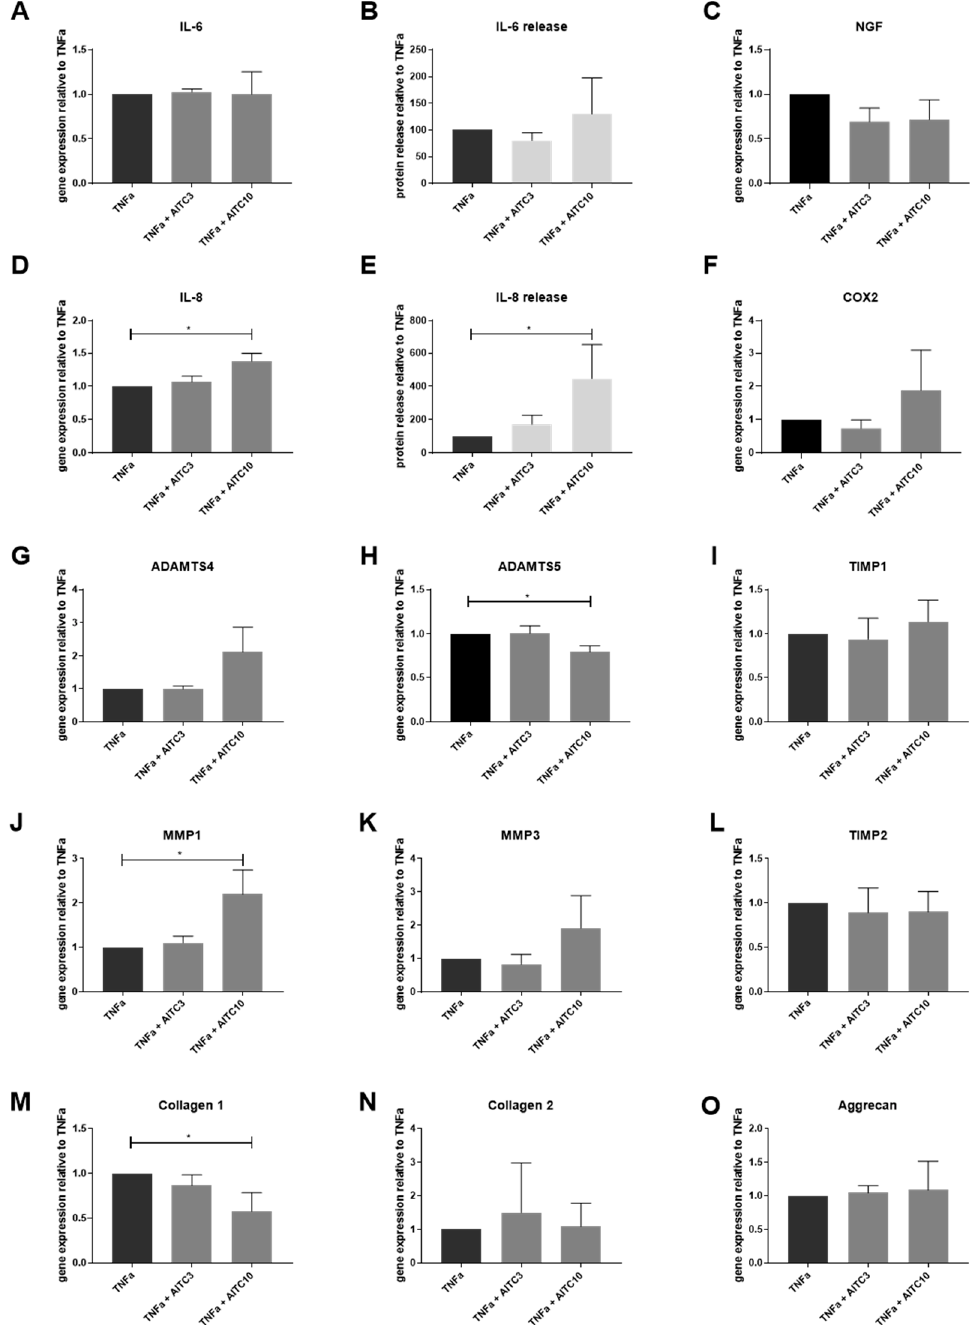
Figure 6. The effects of TRPA1 agonist allyl isothiocyanate (AITC) on gene expression of inflammation markers and ECM molecules in TNF- α -treated cells. Gene expression of ( A ) IL-6 and ( D ) IL-8 in IVD cells treated with 10 ng/mL TNF- α ± 3 or 10 µ M AITC. Protein release of ( B ) IL-6 and ( E ) IL-8 in IVD cells treated with 10 ng/mL TNF- α ± 3 or 10 µ M AITC. Gene expression of ( C ) NGF, ( F ) COX-2, ( G ) ADAMTS4, ( H ) ADAMTS5, ( I ) TIMP1, ( J ) MMP1, ( K ) MMP3, and ( L ) TIMP2, ( M ) COL1A1, ( N ) COL2A1, and ( O ) Aggrecan in IVD cells treated with 10 ng/mL TNF- α ± 3 and 10 µ M AITC. Graphs show gene expression and protein release calculated relative to TNF- α treatment (mean ± SD, n = 3-4). Asterisks indicate statistical significance (* p < 0.05, Kruskal–Wallis test and Dunn’s multiple comparison test).